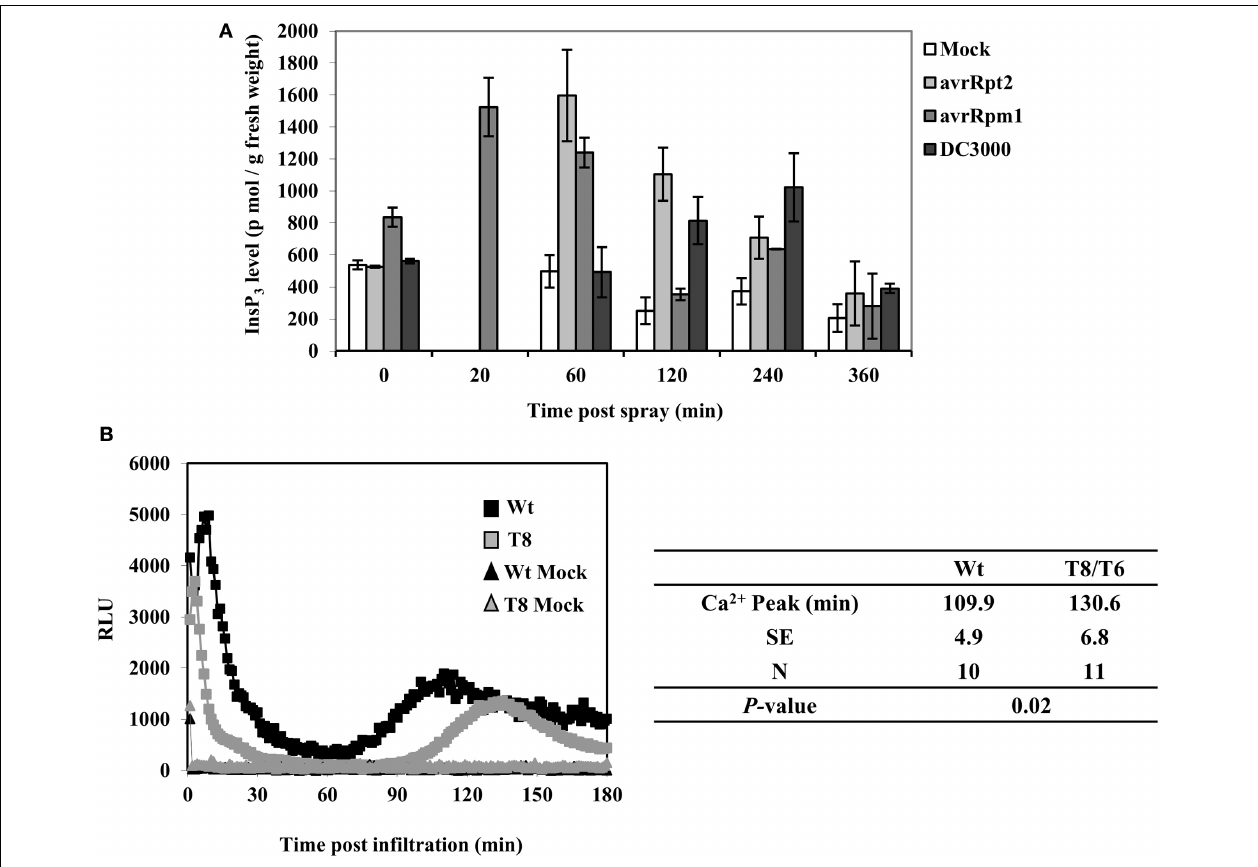
FIGURE 3 | InsP 3 changes and Ca 2 + release in response to avirulent Pseudomonas syringae pv tomato DC3000. (A) Wild type Arabidopsis plants were sprayed with Pst DC3000 or Pst DC3000 + avrRpt2 or + avrRpm1 at a concentration of OD 600 = 0 . 004 (2 × 10 6 cfu/ml). Mock spray was 10mM MgCl 2 . Treated leaves were harvested at different time points and InsP 3 was quantified. Data shown is the average of 5